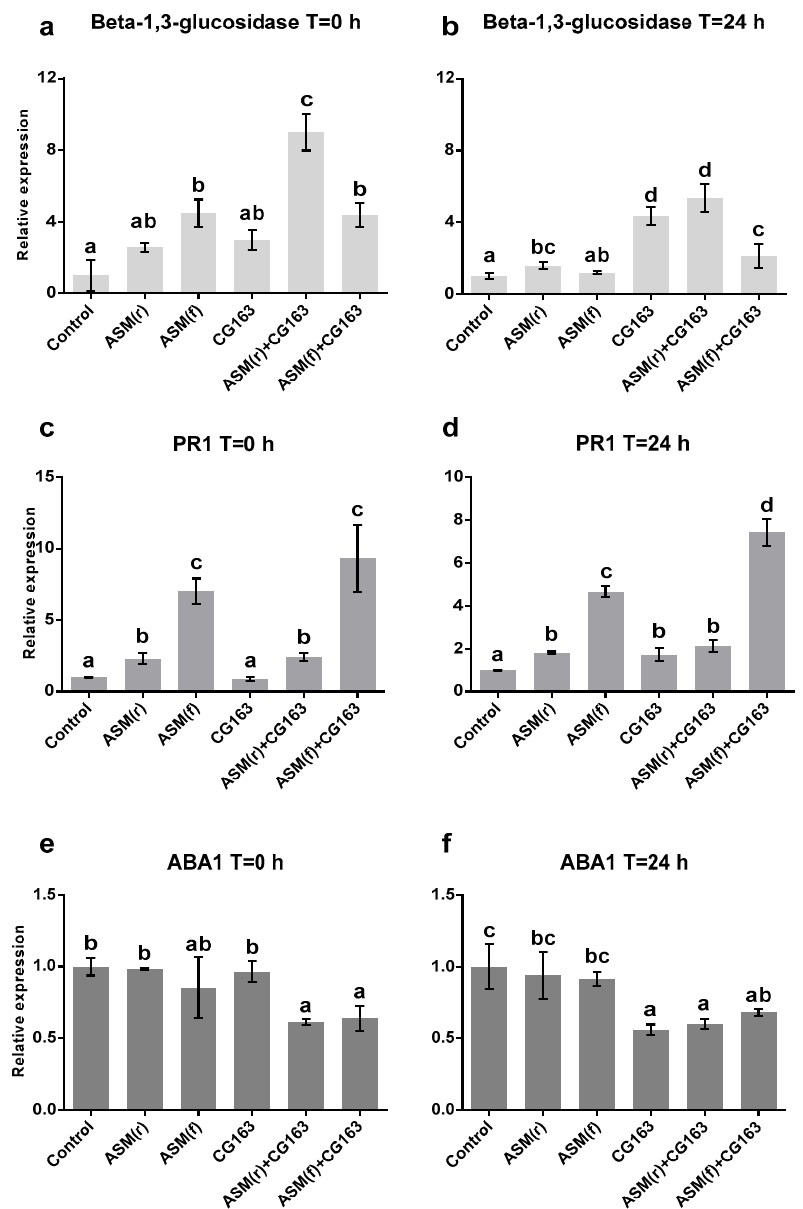
Figure 6. Relative expression of β -1,3-glucosidase ( a , b ), pathogenesis-related protein 1 (PR1) ( c , d ) and abscisic acid deficient 1 (ABA1) ( e , f ) genes in Actinidia chinensis var. deliciosa ‘Hayward’ potted plants treated with acibenzolar-S-methyl (ASM) root (r) or foliar-spray (f), Aureobasidium pullulans isolate CG163 (CG163), combination of ASM (r or f) and CG163 (ASM + CG163) or untreated (control) seven and one day before inoculation with 2 × 10 7 CFU / mL Pseudomonas syringae pv. actinidiae . Relative expression was normalized against 40 s ribosomal protein gene and the protein phosphatase 2A gene. The basal transcript level in untreated plants (baseline treatment) was used as a further reference point for all calculations and is referred to with the value 1. Values are means ± standard errors of three independent biological replicates. Each biological replicate consisted of a pooled leaf sample from two ‘Hayward’ tissue cultures. Molecular samples were taken just before (0 h) and 24 h after Psa inoculation. Bars with di ff erent letters are based on back-transformed average relative expression and are significantly di ff erent according to Fisher’s Least Significant Di ff erence test (LSD) at the 5%